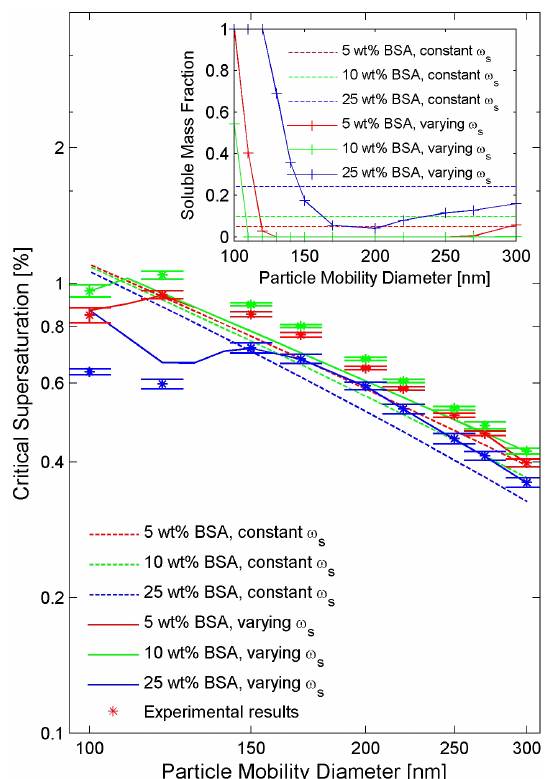
Figure 11. Experimental and theoretical critical supersaturations for mixed silica + BSA particles for different particle mobility di- ameters using the model of Kumar et al. (2011b). Dashed lines represent calculated critical supersaturations based on an assump- tion of constant soluble mass fractions ( ω s ) with changing diam- eter and solid lines show the critical supersaturations based on the size-dependent soluble mass fractions. Error bars represent the min- imum vs. maximum values of supersaturation to estimate the s c cor- responding to each mobility diameter. The inset represents assumed constant soluble mass fractions as well as size-dependent ones cor- responding to the 50% points in the CCN/CN curves for different size vs. supersaturation pairs of mixed silica + BSA